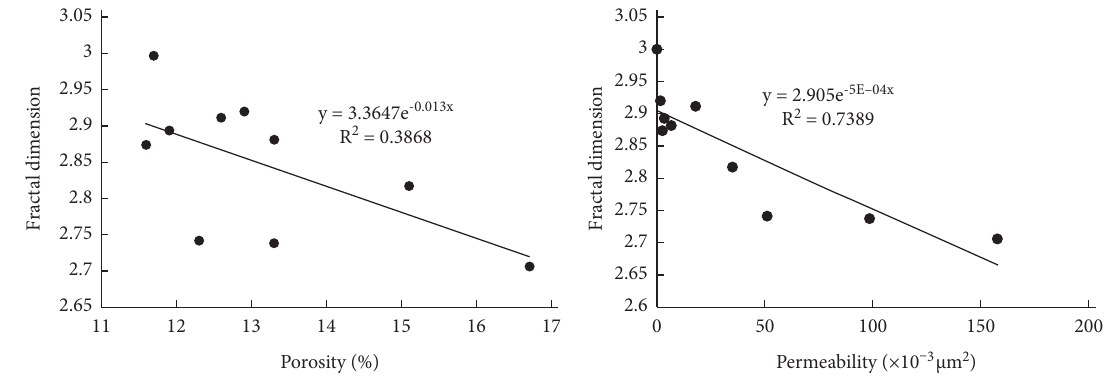
Figure 5: Relationship between reservoir properties and fractal